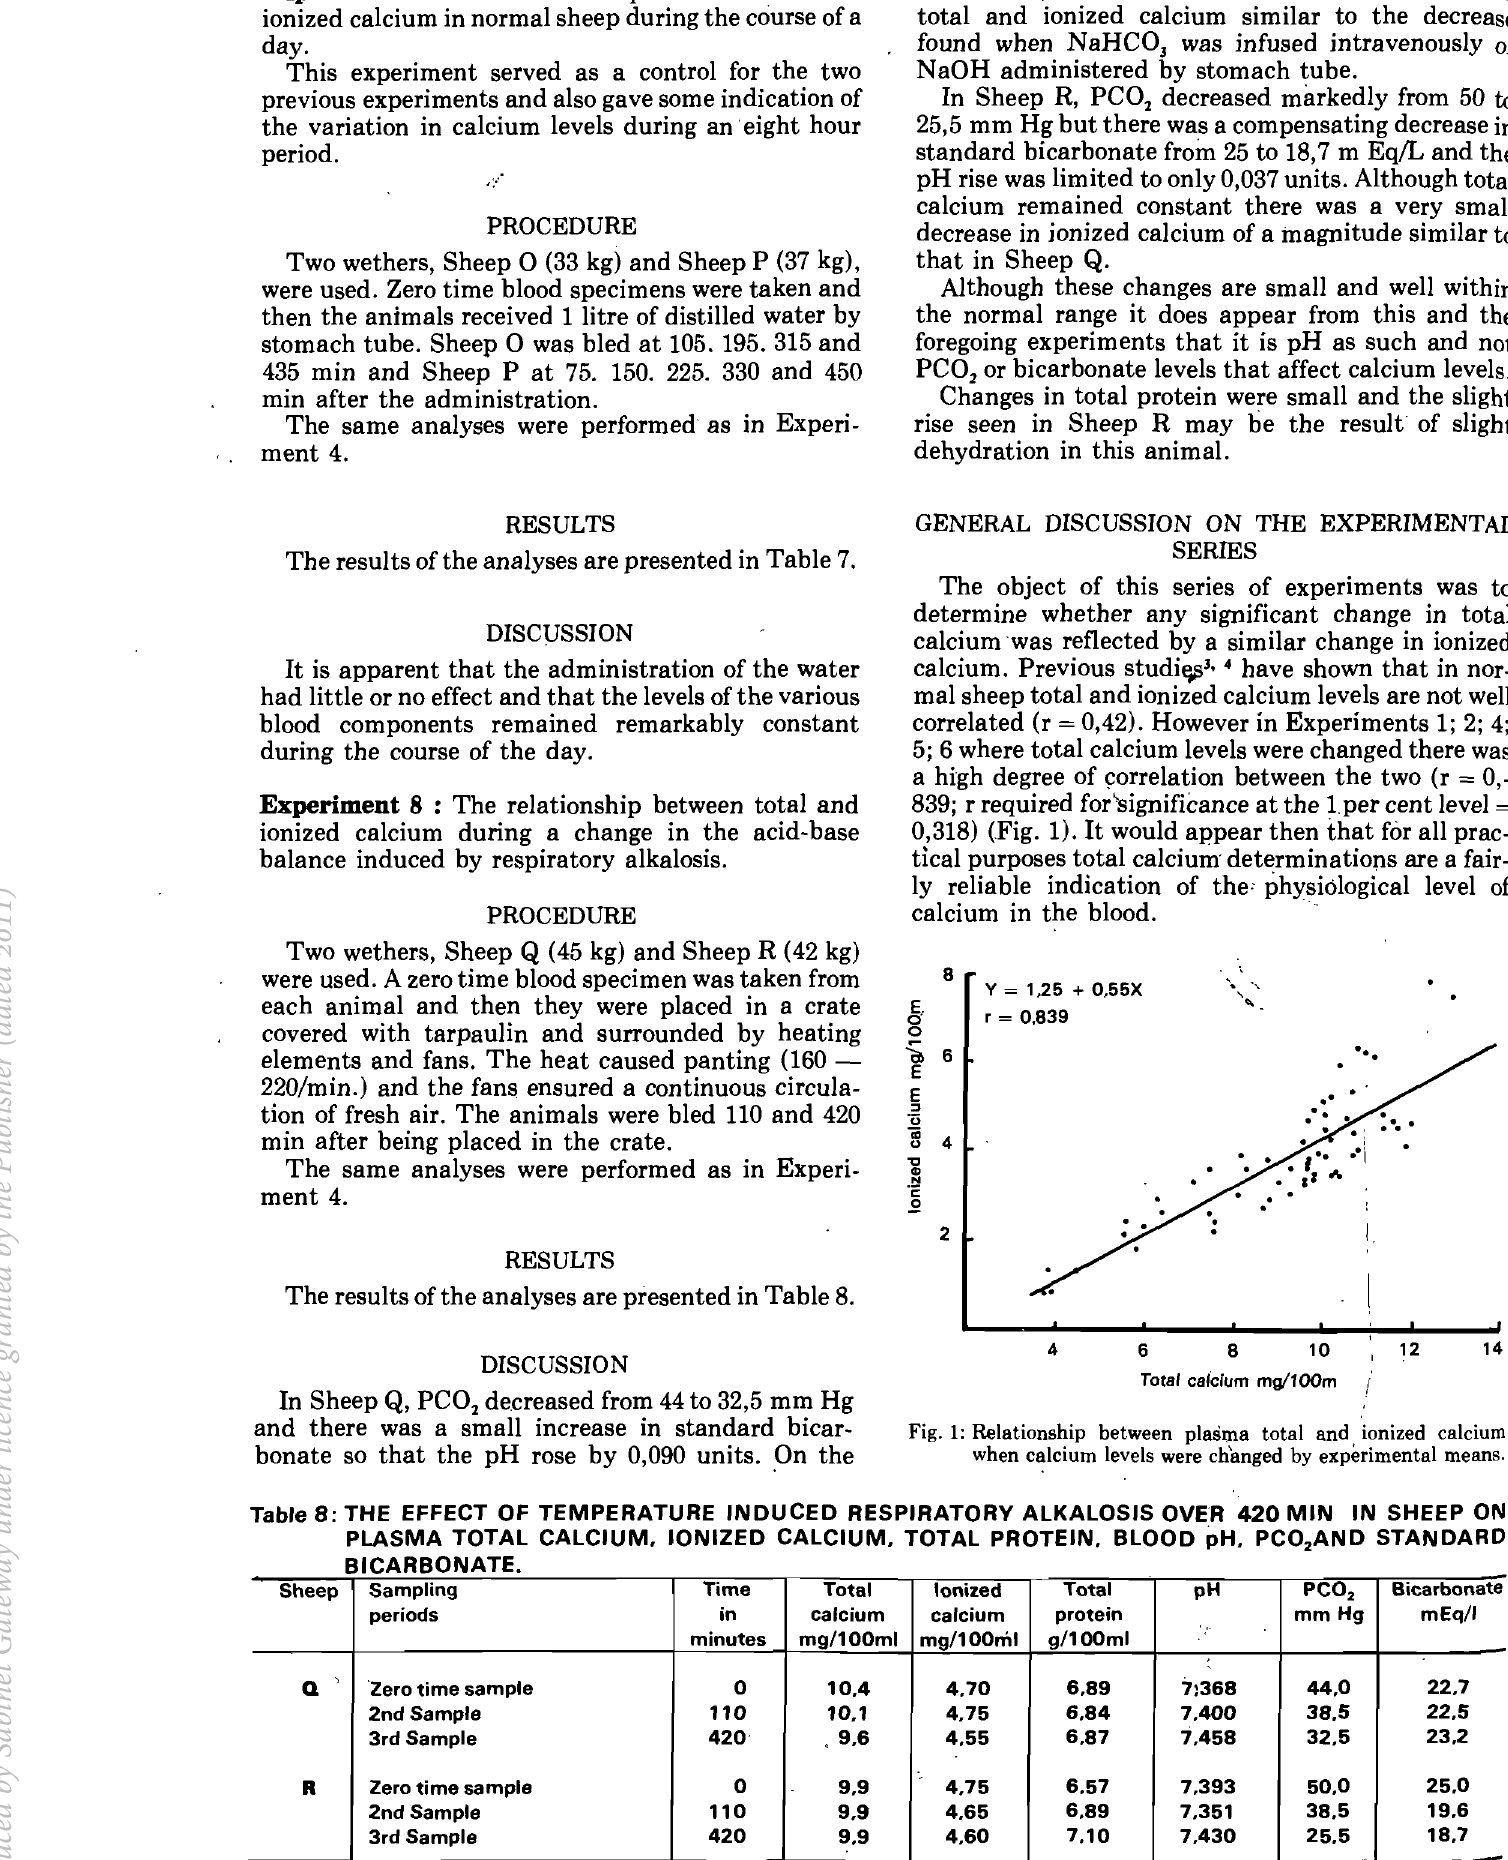
Table 8: THE EFFECT OF TEMPERATURE INDUCED RESPIRATORY ALKALOSIS OVER 420 MIN IN SHEEP ON PLASMA TOTAL CALCIUM. IONIZED CALCIUM. TOTAL PROTEIN. BLOOD pH. PC0 BICARBONATE Sheep